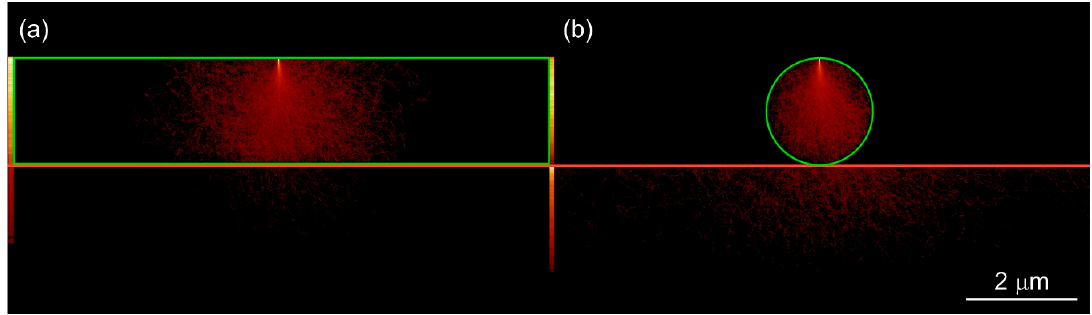
Figure 10. Sections of Monte Carlo simulation of the distribution of Al K α X-ray in ( a ) prismatic fragment with a thickness of 2 µm and 20 keV beam energy, and ( b ) spherical fragment with a 2 µm diameter and 20 keV beam energy, both mounted on an Al substrate. The border of the fragment is in green and the substrate limit is in red.